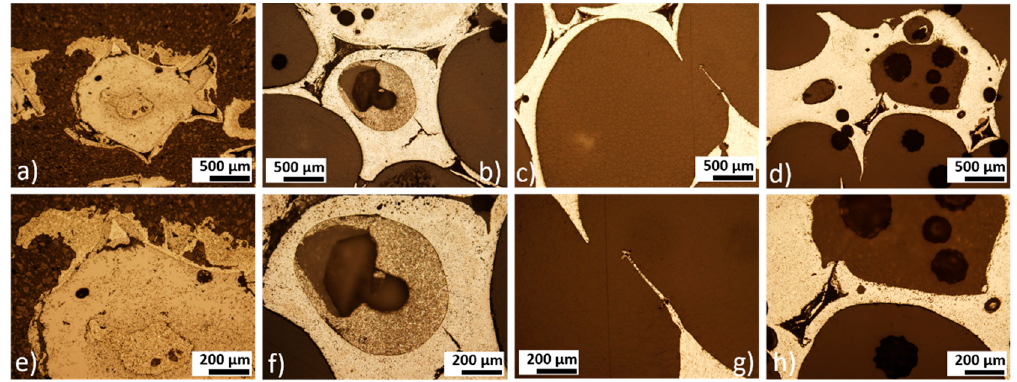
Figure 10. Metallographic cross-sections of the ( a , e ) pure iron; ( b , f ) Fe-PEI1; ( c , g ) Fe-PEI2; and ( d , h )